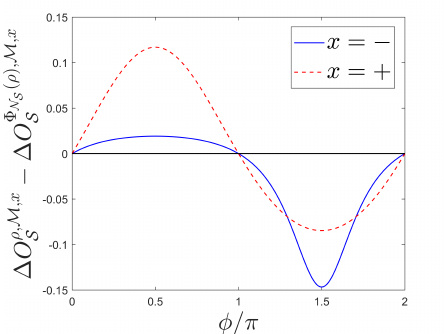
Figure 1. The measurement model for the POVM on H S is M : = ( H A , | ξ (cid:105) , U , Z A ) . Here, the measurement unitary is given as U = e − i ( π /3 ) H I , with the Jaynes Communigs interaction Hamiltonian defined in Equation (13). This conserves the total excitation number N S + N A , defined in Equation (15). The apparatus observable is Z A = | 1 (cid:105)(cid:104) 1 | − | 0 (cid:105)(cid:104) 0 | , with the corresponding outcomes x = ± . The initial state of the apparatus is the coherent state | ξ (cid:105) = cos ( π /6 ) | 1 (cid:105) + sin ( π /6 ) | 0 (cid:105) , while the object system is initially prepared in the coherent state | ψ (cid:105) = cos ( π /8 ) | 1 (cid:105) + e i φ sin ( π /8 ) | 0 (cid:105) . Finally, the system observable is O S = | 1 (cid:105)(cid:104) 1 | − | 0 (cid:105)(cid:104) 0 | . When φ ∈ { 0, π } , the state | ψ (cid:105)(cid:104) ψ | ⊗ | ξ (cid:105)(cid:104) ξ | is symmetric in the excitation number Φ NS ( ρ ) , M , x M , x = ∆ O representation | m , µ (cid:105) , and so by Theorem 2 ∆ O ρ , , with these quantities defined by S S Equaiton